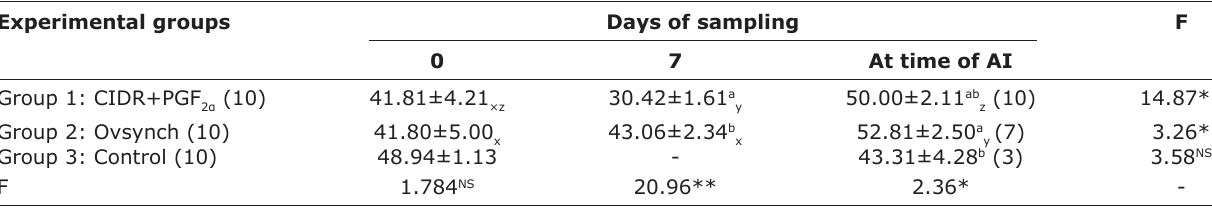
Table-1: Mean serum estrogen concentration (pg/ml) of different experimental groups on different days of sampling in postpartum anestrus cows. Experimental groups Days of sampling